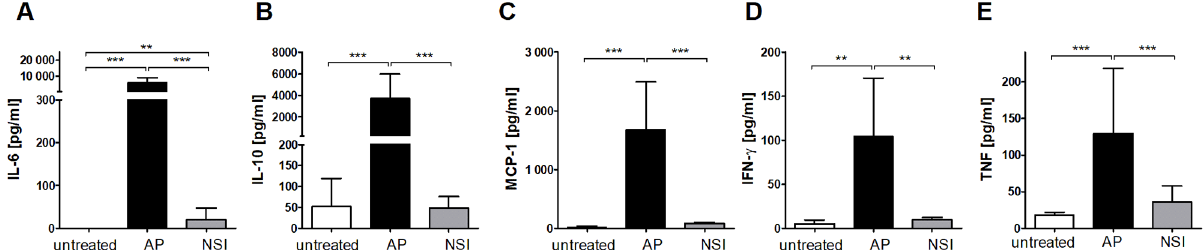
Fig 4. Serum cytokine concentrations 24 h after NSI and AP. C57BL/6 mice were non-specifically immunized (n = 29), or sepsis was induced by AP (n = 23). Untreated animals (n = 12) served as controls. 24 h after NSI or AP, respectively, cytokine concentrations of IL-6 (A), IL-10 (B), MCP-1 (C), IFN- γ (D) and TNF (E) and were determined in serum by CBA. Means and the 95% confidence intervals are shown. Group differences were tested for significance with the Kruskal-Wallis test and Dunn’s multiple comparison for selected pairs. Pooled results from two separate experiments are shown. (cid:3)(cid:3)(cid:3) P < 0.001; (cid:3)(cid:3) P < 0.01.